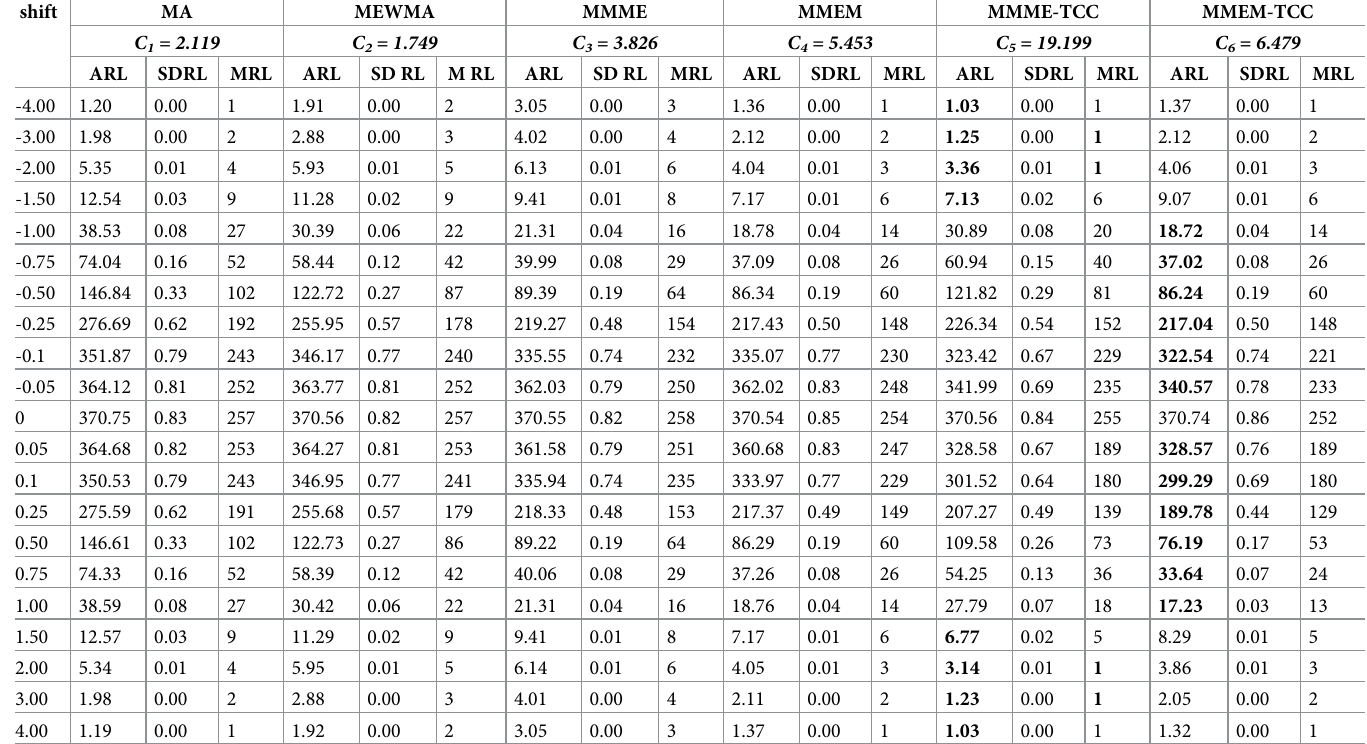
Table 2. The run length attributes of the proposed MMEM-TCC chart and existing control charts for Laplace